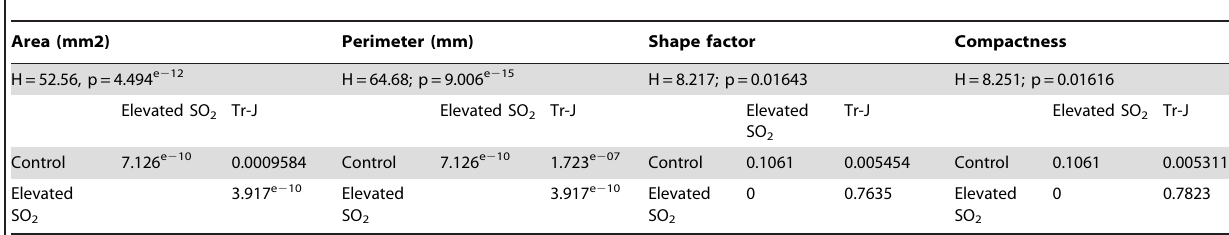
Table 4. Kruskal Wallis and Mann-Whitney pair-wise comparisons for each physiognomic trait in Nageia nagi in the different simulated palaeoatmospheric